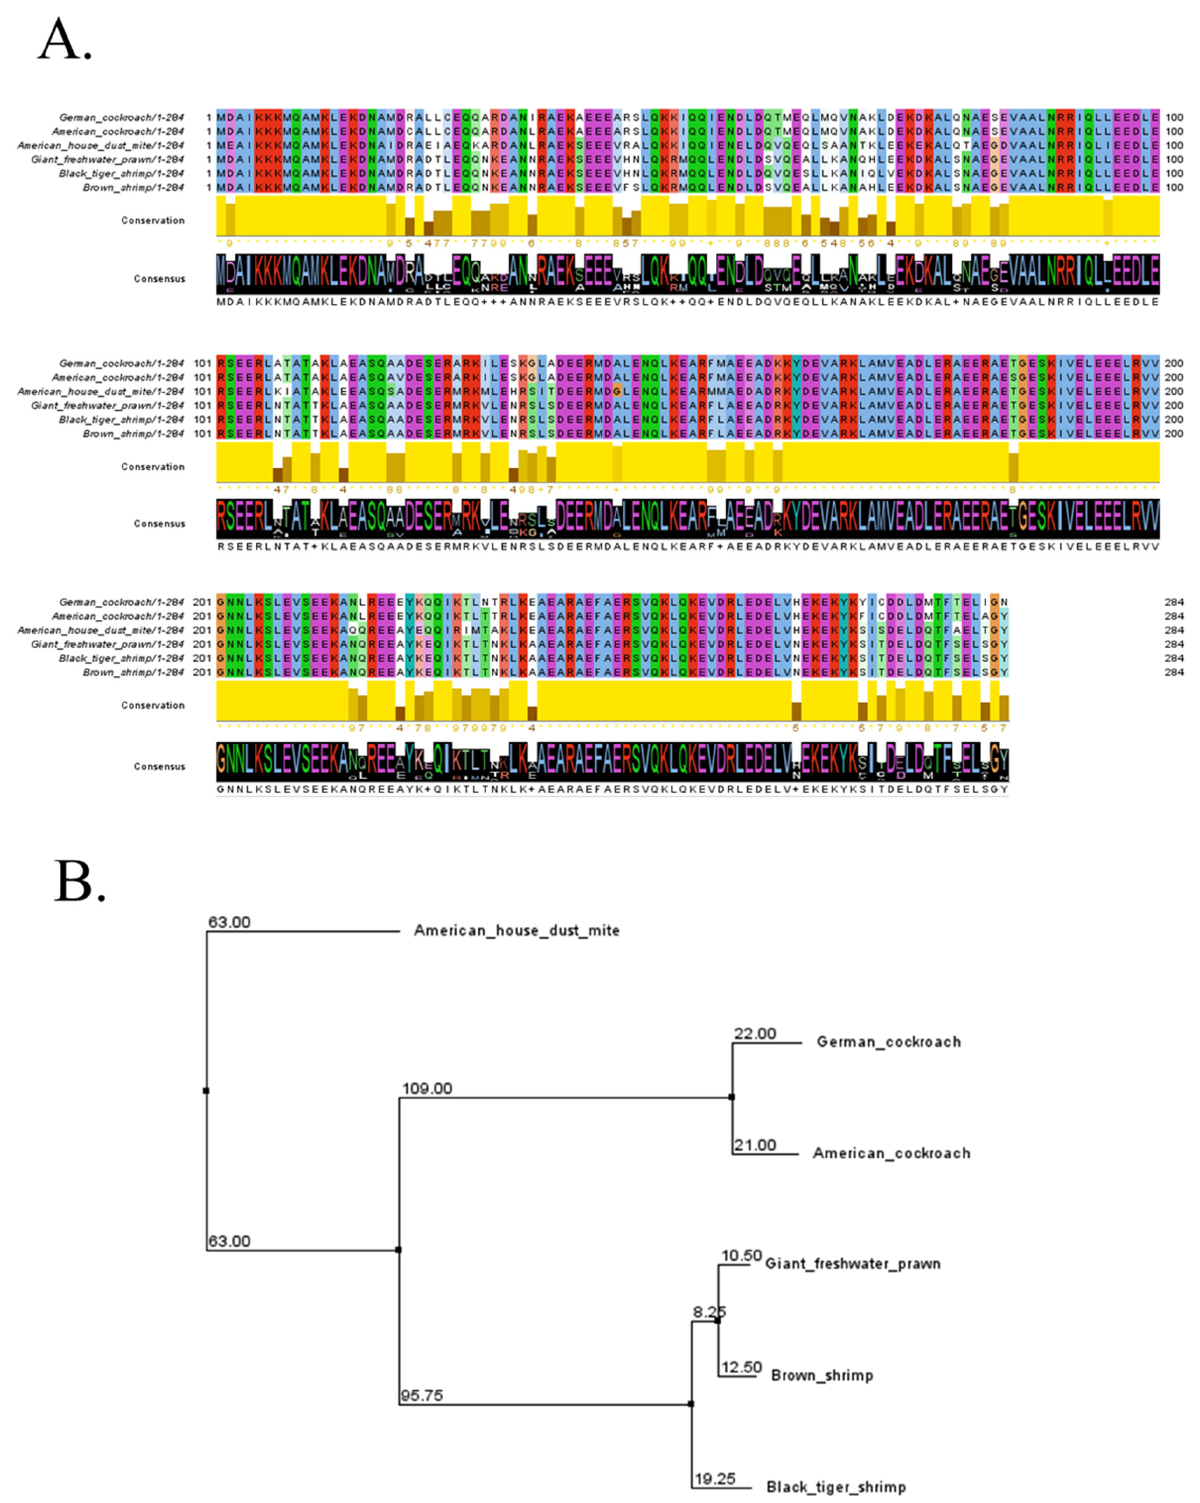
Figure 1. Multiple sequence alignment of tropomyosin from different species selected in this study. ( A ) Protein sequences of tropomyosin from selected species were aligned using Clustal Omega. The conservation of amino acids was indicated as the conservation bar. The consensus sequences were also demonstrated. ( B ) Phylogenetic tree derived from BLOSUM62 matrix based on tropomyosin amino acid sequences.